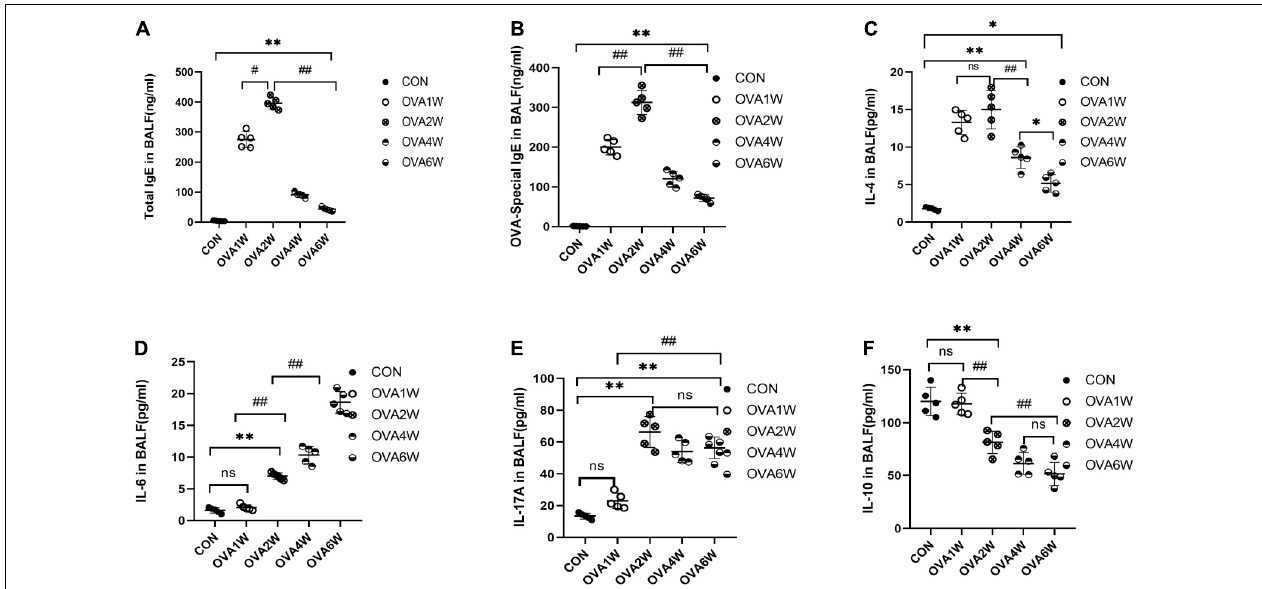
FIGURE 7 | Levels of IgE and inflammatory cytokines in BALF samples. BALF was collected from control mice and OVA-challenged asthmatic mice to measure the levels of total IgE (A) , OVA-specific IgE (B) , IL-4 (C) , IL-6 (D) , IL-17A (E) , and IL-10 (F) using ELISA. Data are expressed as mean ± SD, tested using one-way